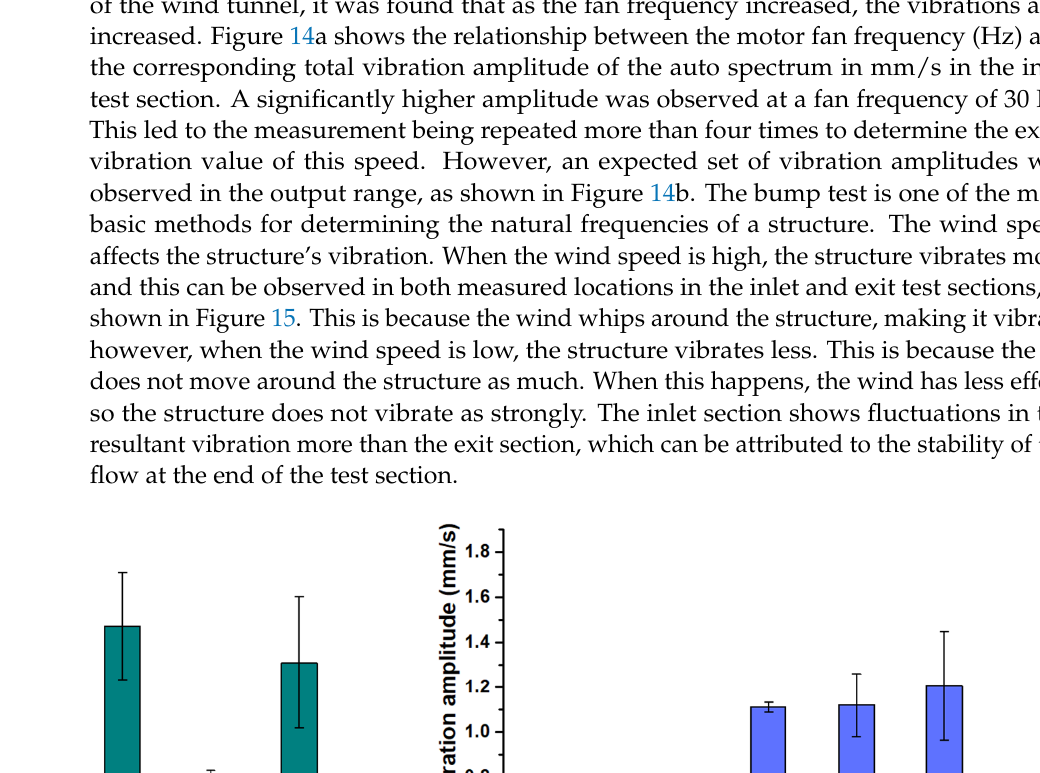
Figure 15. The vibration amplitude fluctuation versus the wind velocity. Resonance occurs when an excited frequency meets a structure ’ s natural frequency. In the present case, the structure ’ s resonant frequency before the inlet section is about 30 Hz. Therefore, when the fan frequency reaches the same value, a dominant amplitude is